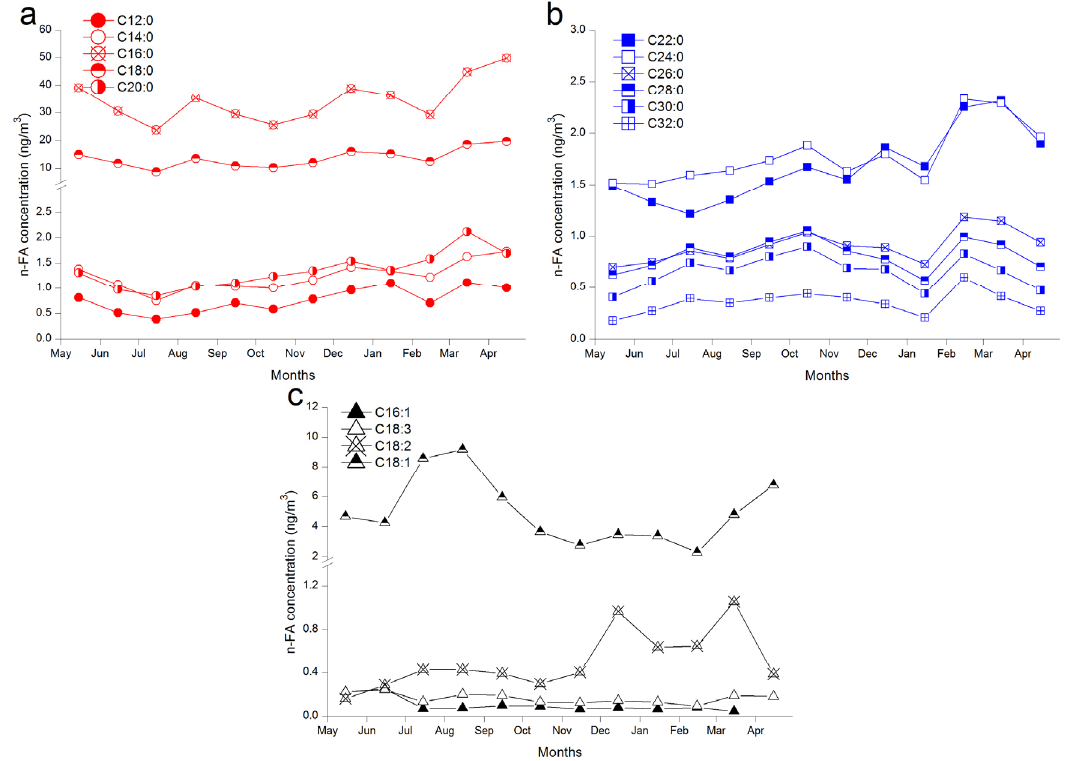
Figure 4. Temporal variations in individual n -FA concentrations of ambient air aerosols in south coastal Xiamen. ( a ) short-chain saturated homologs; ( b ) long-chain saturated homologs; and ( c ) unsaturated homologs.